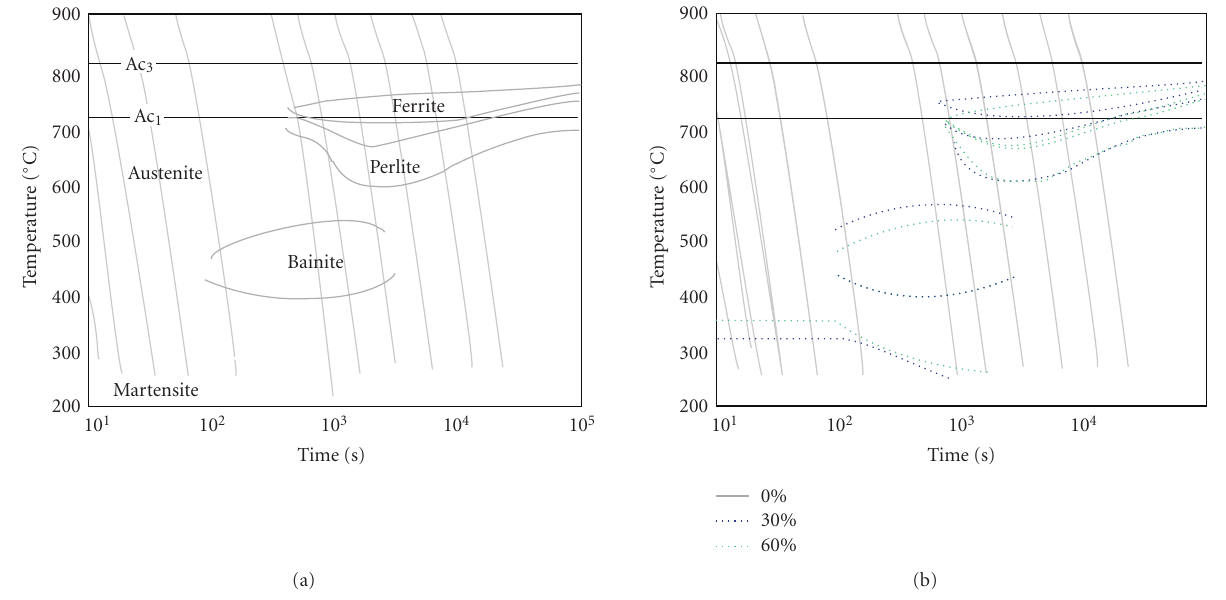
Figure 1: Continuous cooling transformation diagrams of tempering steel 50CrMo4 for deformation of 30%, 60%, and 0%, respectively [7].